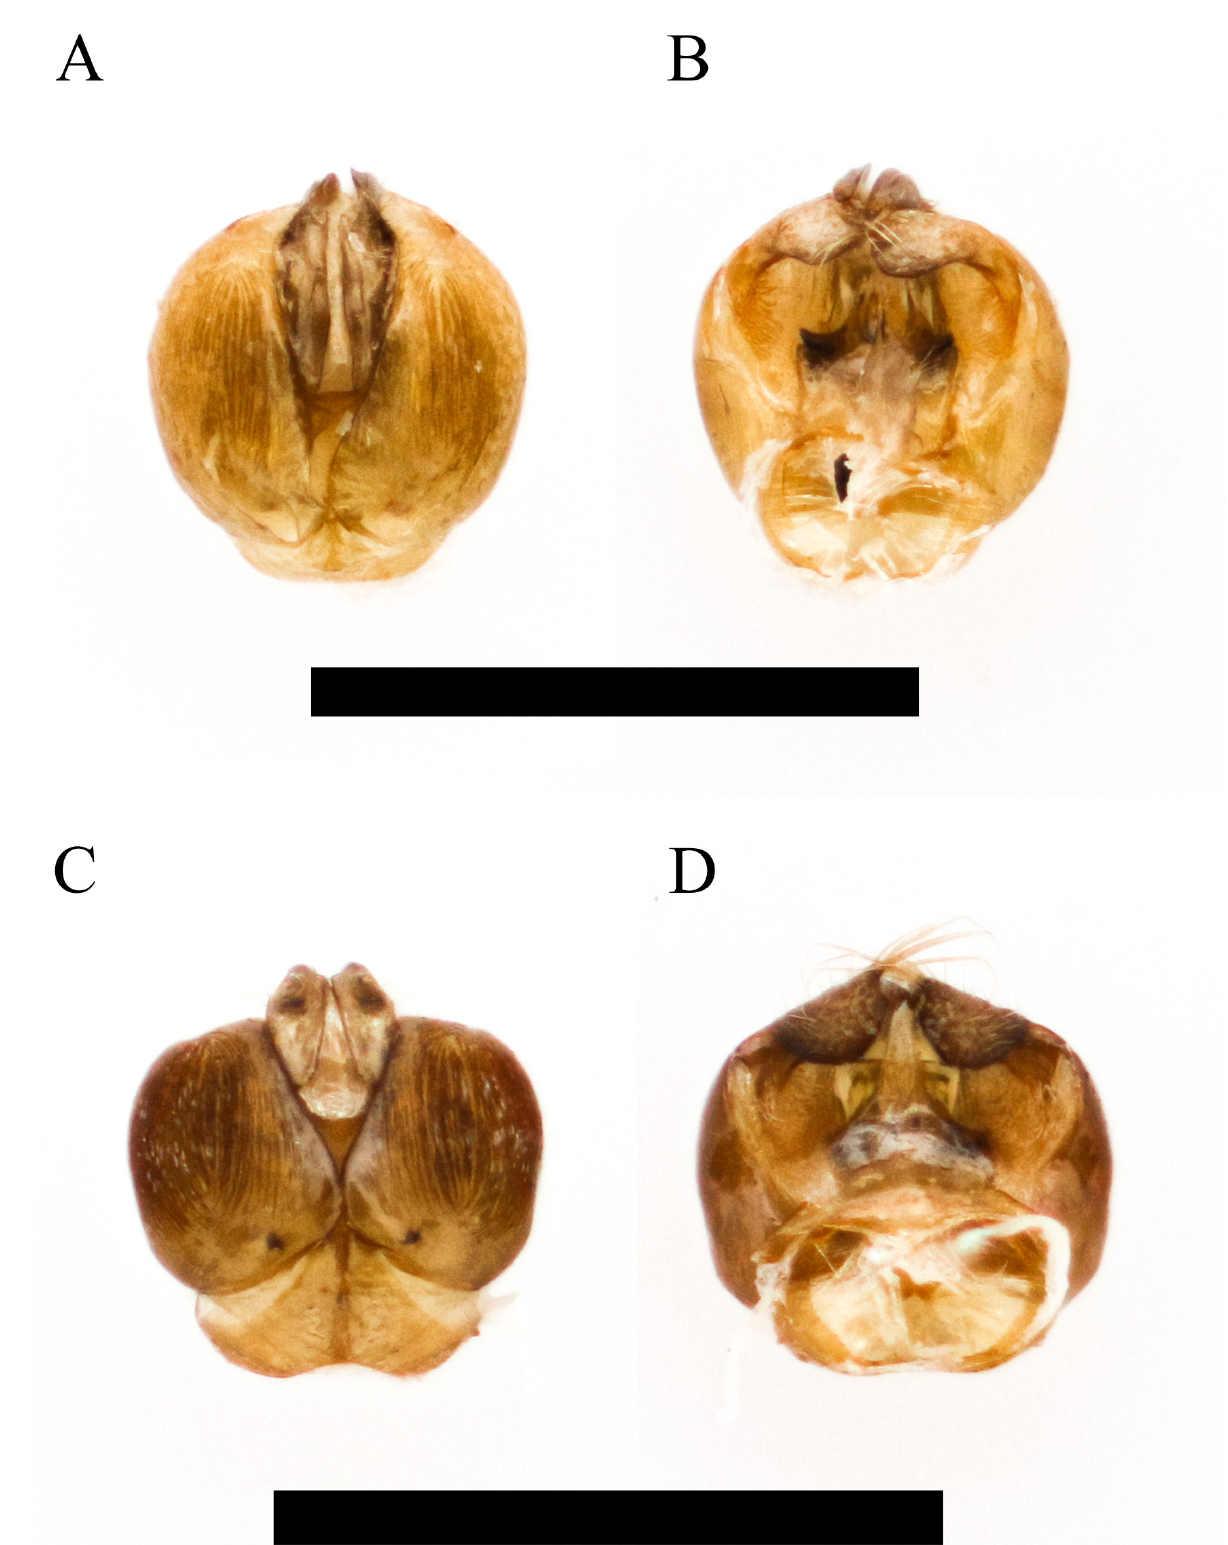
Fig. 14. — Genital capsule of Sphecodes diablotinus sp. nov. Paratype, ♂. A . Dorsal view. B . Ventral view. — Genital capsule of Sphecodes albifacies sp. nov. Paratype, ♂. C . Dorsal view. D . Ventral view. Scale bars = 1